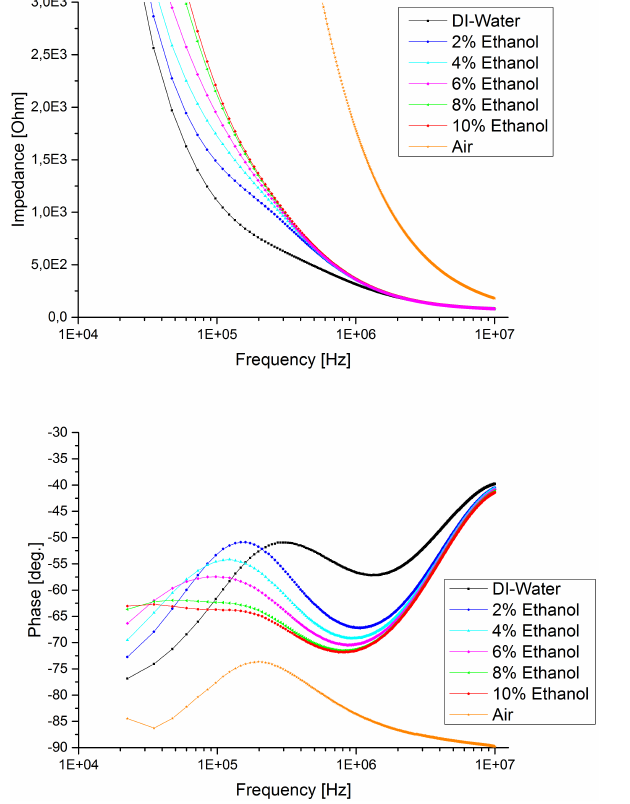
Figure 9. Impedance and phase measurement of water, air, and a mixture of water and ethanol in a series of Bode